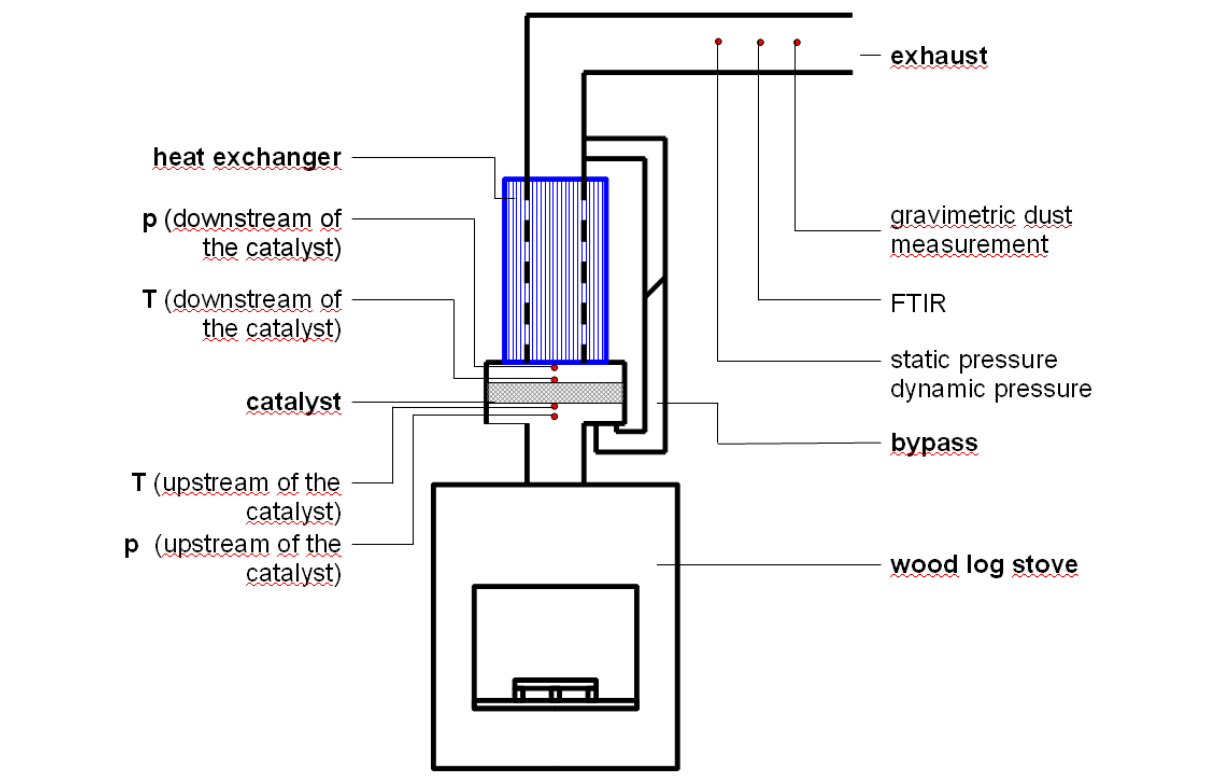
Figure 14. Schematic illustration of the combination of wood log stove and retrofit system